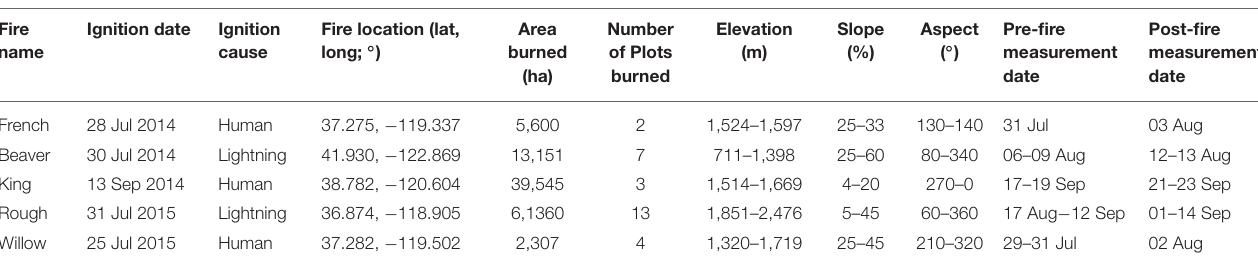
TABLE 1 | Fire and location information a for the five wildfires used in this